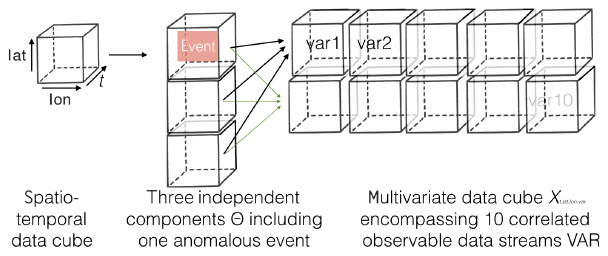
Figure 1. Combination of three independent component cubes to derive 10 correlated variables X as observable measurements. The anomalous event is propagated into some variables of X